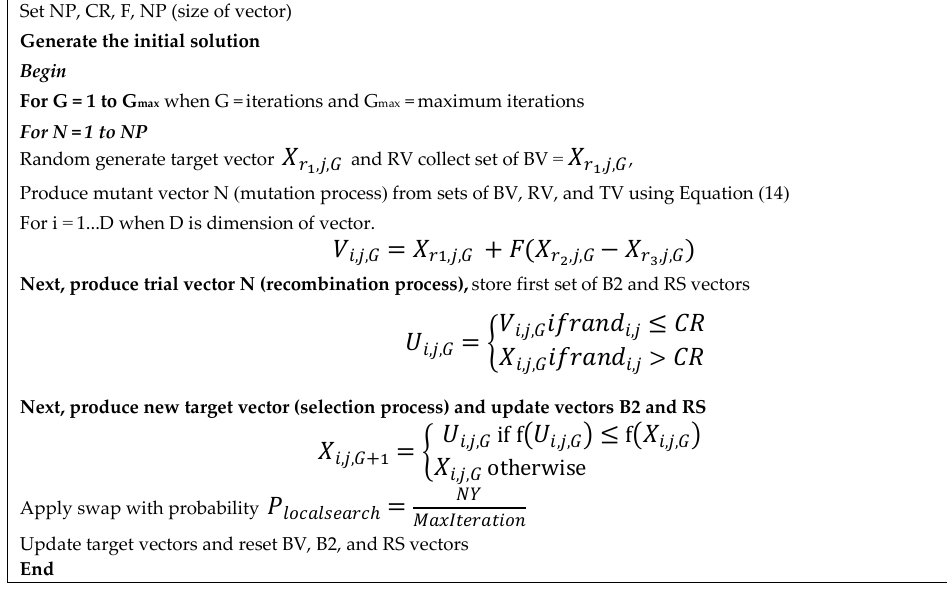
Figure 4. Pseudo-code of modified